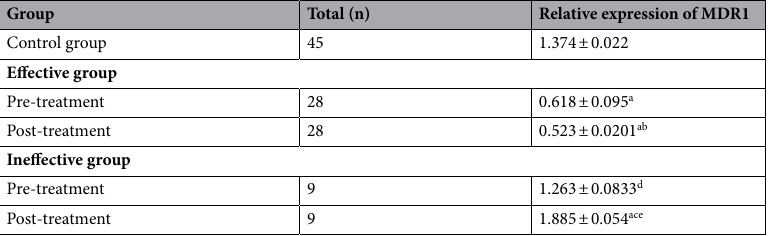
Table 9. Effect of immunosuppressive agents on the expression of MDR1 gene in UC (mean ± SD). a P < 0.05 versus control group. b P > 0.05 versus pre-treatment. c P < 0.05 versus pre-treatment. d P < 0.05 versus effective group pre-treatment. e P < 0.05 versus effective group